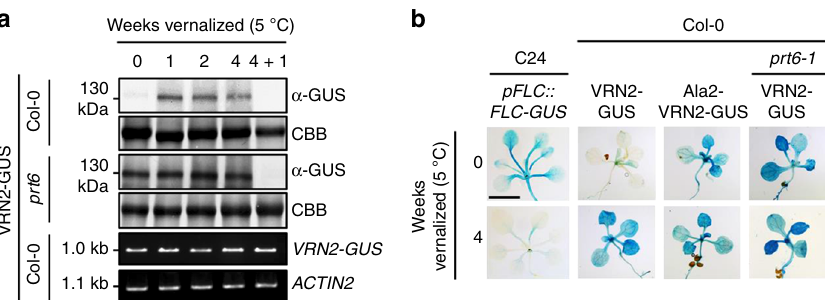
Fig. 3 The N-end rule pathway restricts VRN2 accumulation under non-vernalizing conditions. a Protein and mRNA levels of WT VRN2-GUS in vernalized (1 – 4 weeks) Col-0 and prt6-1 seedlings. 4 + 1 refers to 1 week ‘ recovery ’ at 22 °C following vernalization. b Histochemical staining of seedlings expressing pFLC::FLC-GUS (C24 background), and WT or mutant (Ala2) VRN2-GUS in Col-0 and prt6-1 , ±4 weeks vernalization. Scale bar 5 mm. See also Supplementary Figure 2c for biological reps. Source data are provided as a Source Data